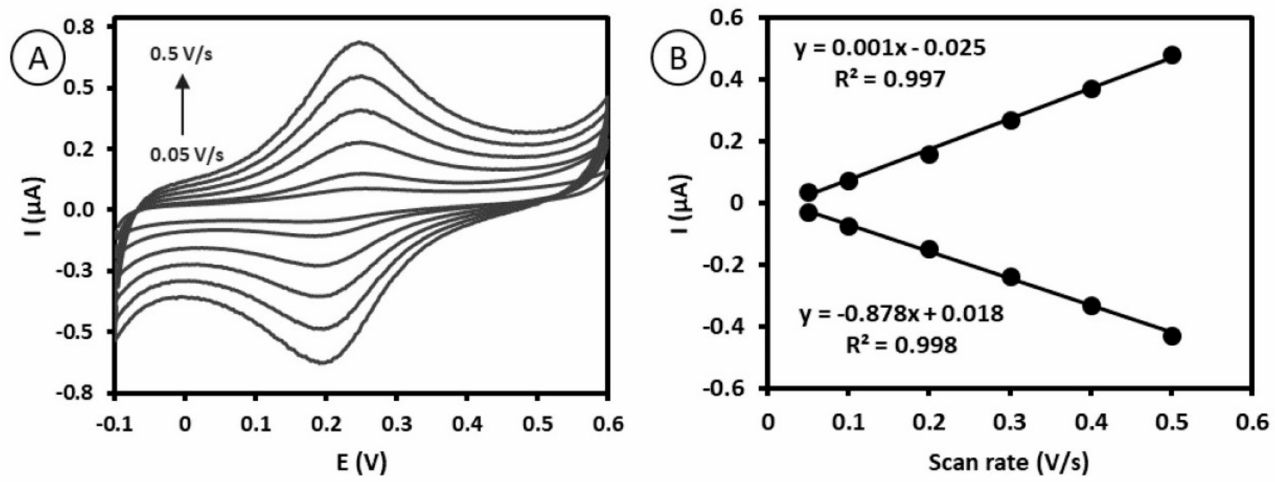
Figure 2. ( A ) Cyclic voltammograms of the immunosensor Au/4-ATP/AbM-anti-ApoB-Fc/BSA recorded at various scan rates: 0.05, 0.1, 0.20, 0.3, 0.4, 0.5 V/s. Supporting electrolyte: 0.1 M sodium phosphate buffer + 0.15 M Na 2 SO 4 , pH 7.0. ( B ) Plots of the oxidation and reduction peak current of ferrocene attached to antibodies vs. scan